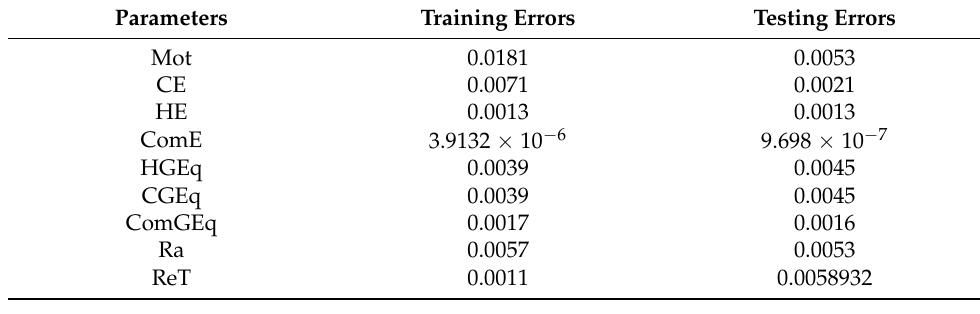
Table 13. Training and testing errors.